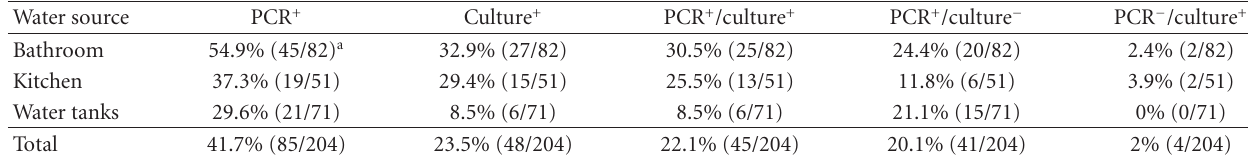
Table 1: Comparison of culture method with real-time PCR for the detection of Legionella spp.